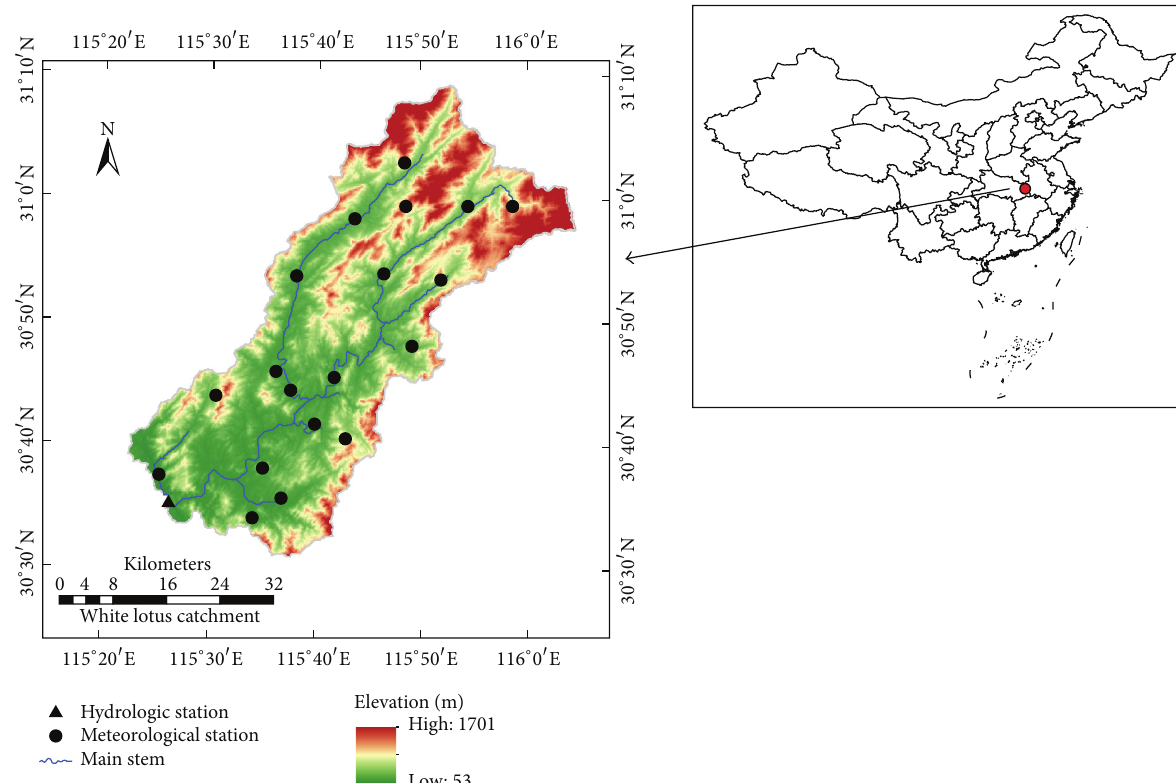
Figure 1: Location of White Lotus River catchment and the meteorological and river gauging stations within the catchment.